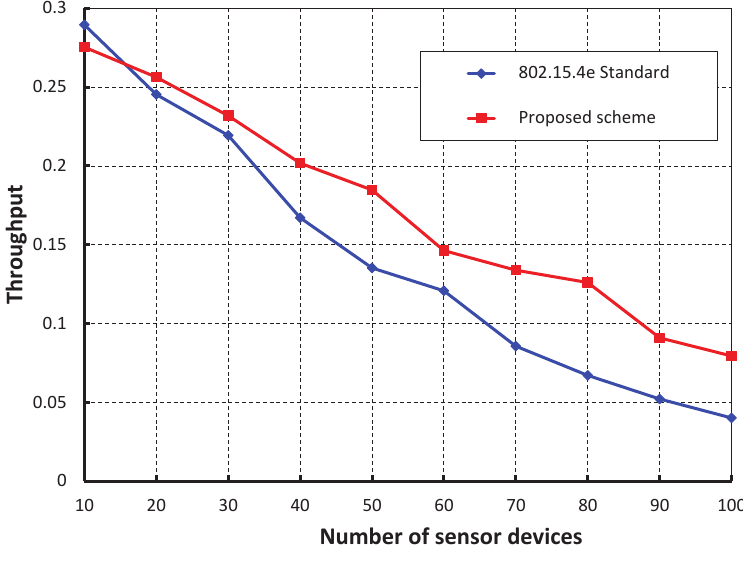
Figure 9. Comparison of throughput of our proposed scheme with the IEEE 802.15.4e standard.